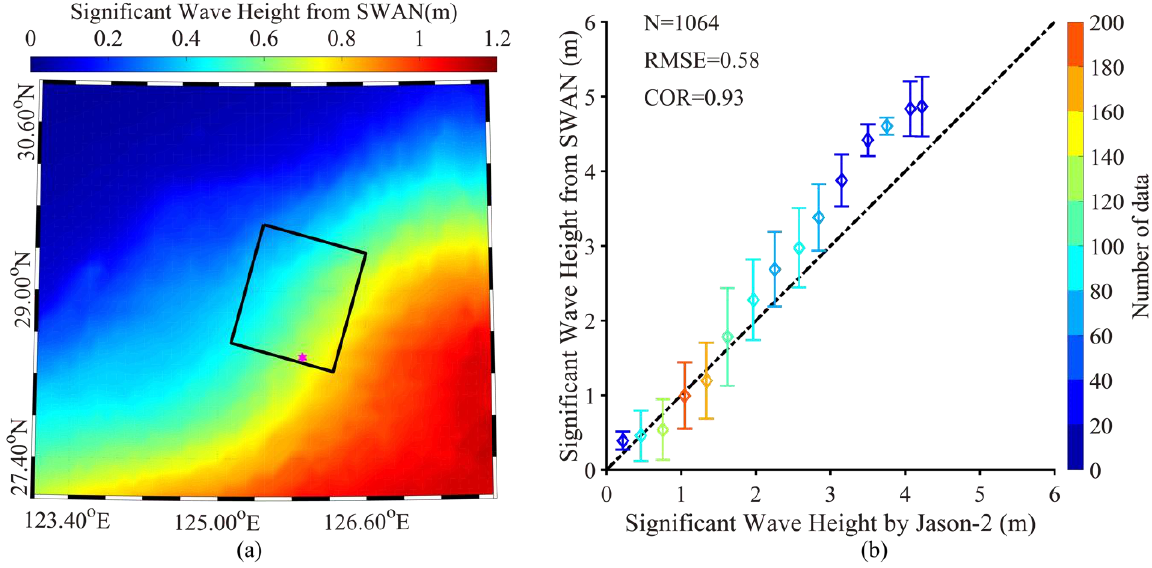
Figure 6. ( a ) The model-simulated SWH map from SWAN taken on 14 January at 22:30, in which the black rectangle represents the spatial coverage of the corresponding GF-3 SAR image and the pinkish marks represent the shipwreck position; ( b ) The comparison between SWHs simulated by the SWAN and the Jason altimeter data for a 0.3-m bin, in which the error bars represent the standard deviations of each bin for the matchups in the black rectangle in Figure 3.